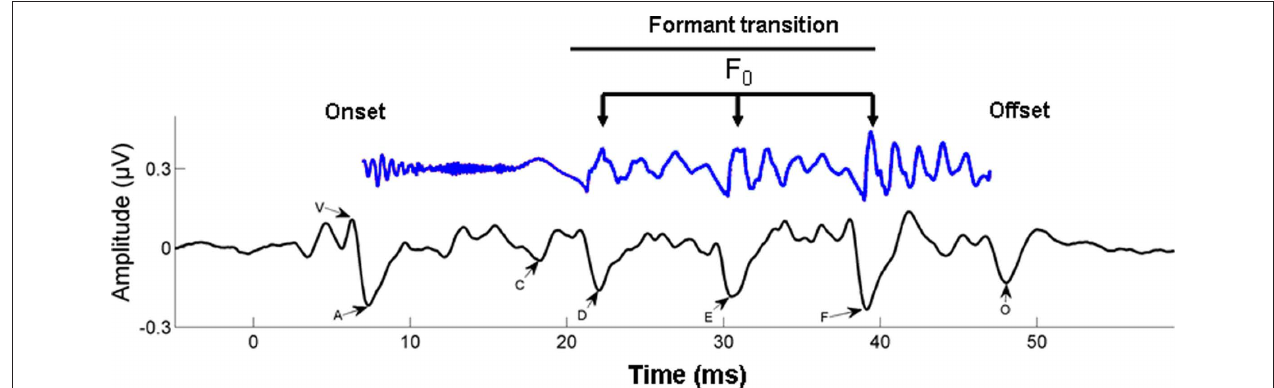
FiguRE 4 | Time–amplitude waveform of a 40-ms synthesized speech stimulus /da/ is shown in blue (time shifted by 6 ms to be comparable with the neural response). The first 10 ms of the syllable are characterized by the onset burst of the consonant /d/; the following 30 ms are the formant transition to the vowel /a/. The time–amplitude waveform of the time-locked brainstem response to the 40-ms /da/ is shown below the stimulus, in black. The onset response (V) begins 6–10 ms following the stimulus, reflecting the